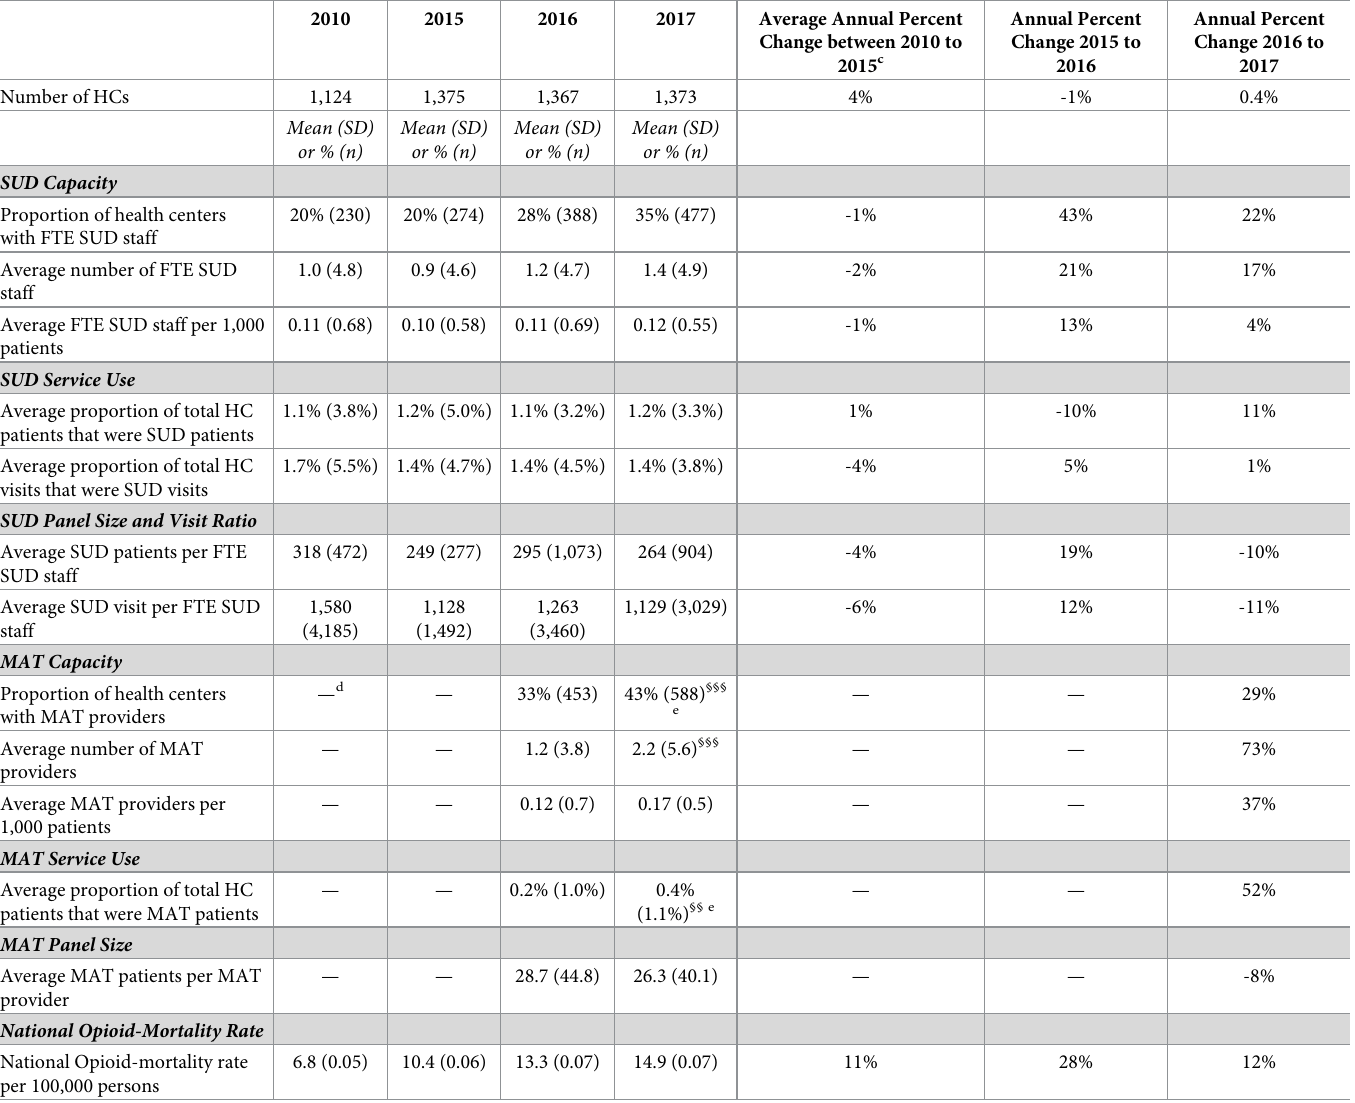
Table 1. Provision of Substance Use Disorder (SUD) and Medication-Assisted Treatment (MAT) services by federally-funded Health Centers (HCs) in the United States in 2010 and 2015 to 2017 a,b